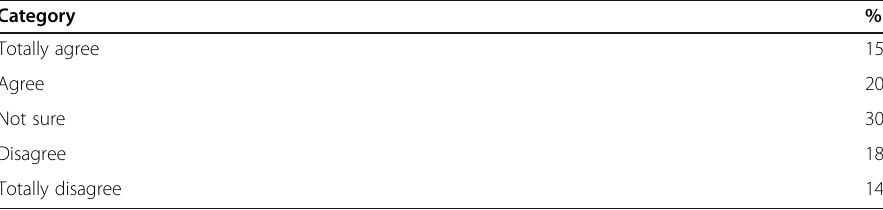
Table 11 IELTS test has limited my English learning